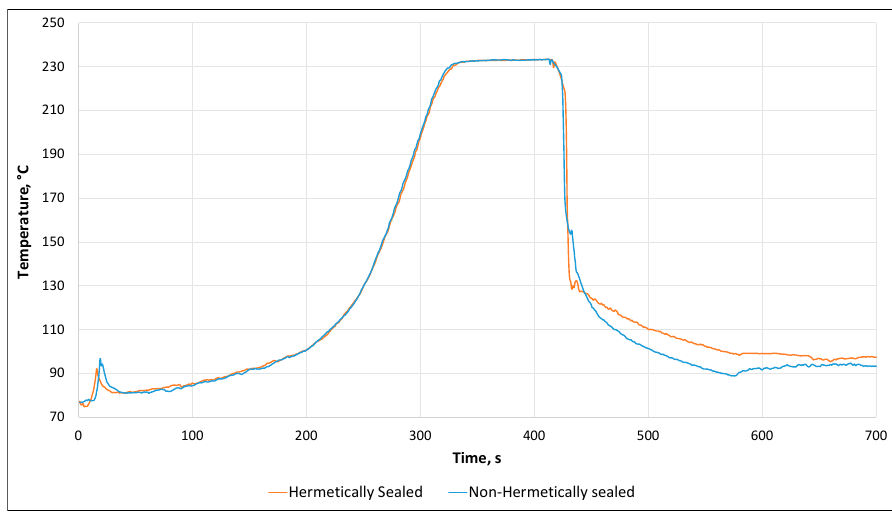
Figure 10. Comparison between the temperature curves (soldering profiles) at the sealed and non-sealed state of the oven.